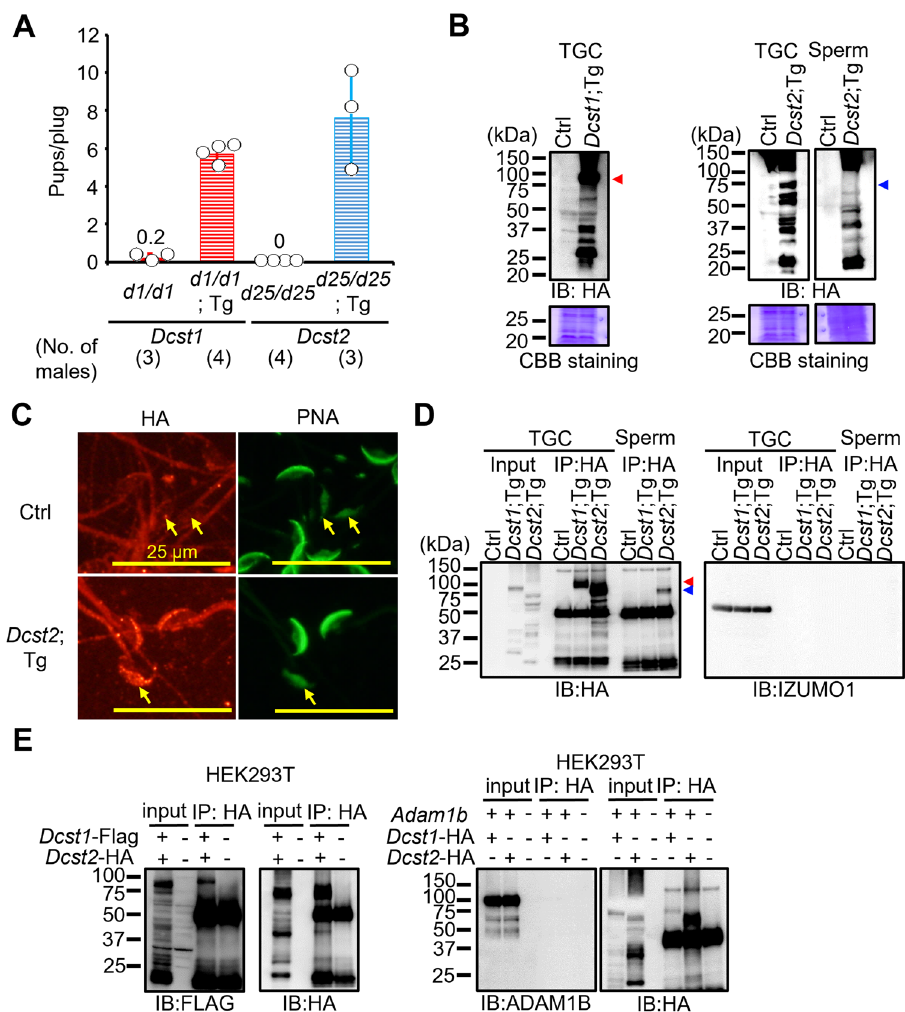
Fig. 3 Detection of DCST1/2 in TGC and sperm and interaction of DCST1/2. A Rescue of male fertility. Dcst1 d1/d1 males with Dcst1 -3xHA Tg insertion and Dcst2 d25/d25 males with Dcst2 -3xHA Tg insertion were generated (Fig. S10), and their fertility was rescued [number of plugs: 17 ( Dcst1 d1/d1 ), 25 ( Dcst1 d1/d1 ;Tg), 42 ( Dcst2 d25/d25 ), 15 ( Dcst2 d25/d25 ;Tg)]. The fecundity data in Dcst1 d1/d1 and Dcst2 d25/d25 males is replicated from Fig. 1C. All values are shown as the mean±SD. B Detection of DCST1 and DCST2 in TGC and sperm. The protein extract of TGC (100 μ g) and sperm (6.6×10^6 sperm) was used for SDS-PAGE. The HA- tagged DCST1 and HA-tagged DCST2 were detected in TGC and sperm. Total proteins in the membrane were visualized by CBB staining. Triangle marks show the expected molecular size of DCST1 (about 80kDa) and DCST2 (about 77kDa). C Localization of DCST2 in sperm. The HA-tagged DCST2 was localized in the anterior acrosome before the acrosome reaction, and then translocated to the equatorial segment in acrosome-reacted sperm (arrows). Wild-type sperm were used as the negative control. PNA was used as a marker for the acrosome reaction. The fl uorescence in the sperm tail was non-speci fi c. The scale bars are 25 μ m. D Co-IP and western blotting of the interaction between IZUMO1 and DCST1/2. The TGC and sperm lysates from Ctrl ( Dcst2 wt/wt and d25/wt mice), Dcst1 ;Tg, and Dcst2 ;Tg males were incubated with anti-HA tag antibody-conjugated magnetic beads, and then the eluted protein complex was subjected to western blotting. The HA-tagged DCST1 was detected only in the IP product from TGC, and the HA-tagged DCST2 was detected in the IP-product from TGC and sperm. IZUMO1 was not detected in the co-IP products. Red and blue triangle marks show the expected molecular size of DCST1 (about 80kDa) and DCST2 (about 77kDa), respectively. E Interaction between DCST1 and DCST2 in HEK293T cells. The protein lysate collected from HEK cells overexpressing Dcst1 -3xFLAG and Dcst2 -3xHA was incubated with anti-HA tag antibody-conjugated magnetic beads. The FLAG-tagged DCST1 was detected in the eluted protein complex. ADAM1B, a sperm protein that localizes to the sperm surface and is not involved in sperm-egg fusion, was used for negative